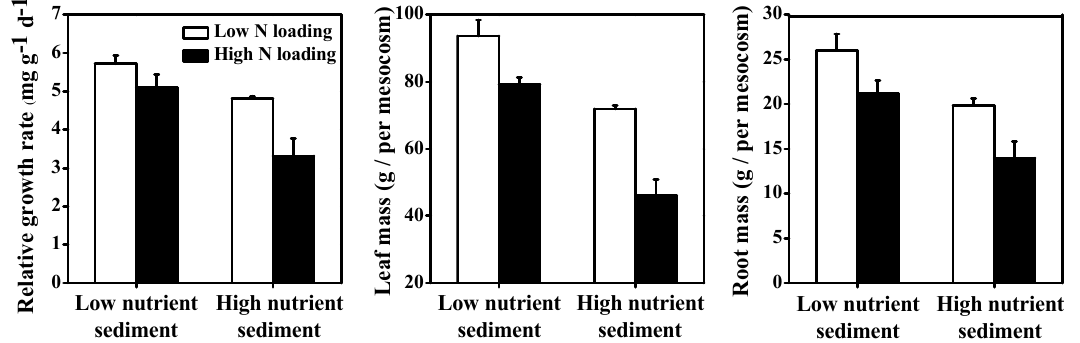
Figure 3. Relative growth rate, leaf mass and root mass of V. natans grown in two nutrient sediments (low and high nutrient sediment) and with two levels of nitrogen loading (low and high N loading). Blank column represents low N loading; black column represents high N loading. Values are mean ± SD, n = 4, and the bars show standard deviation.